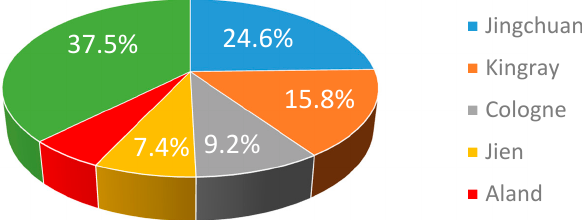
Figure 29. Market shares of Chinese domestic spherical Ni(OH) 2 producers in 2013 [13].